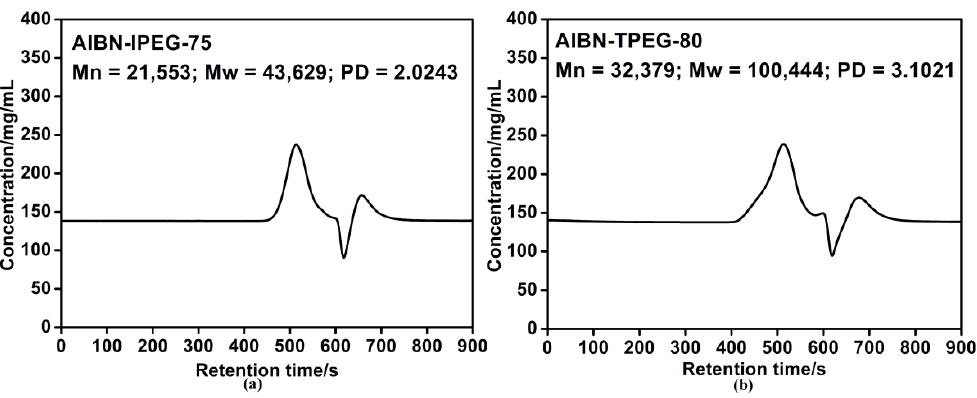
Figure 4. Molecular weight of PCEs: ( a ) AIBN + IPEG; ( b ) AIBN + TPEG (PCE samples: